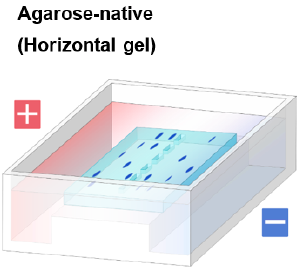
Figure 3. Schematic illustration of horizontal gel. Agarose gels in horizontal mode were prepared on Mupid flat tray.